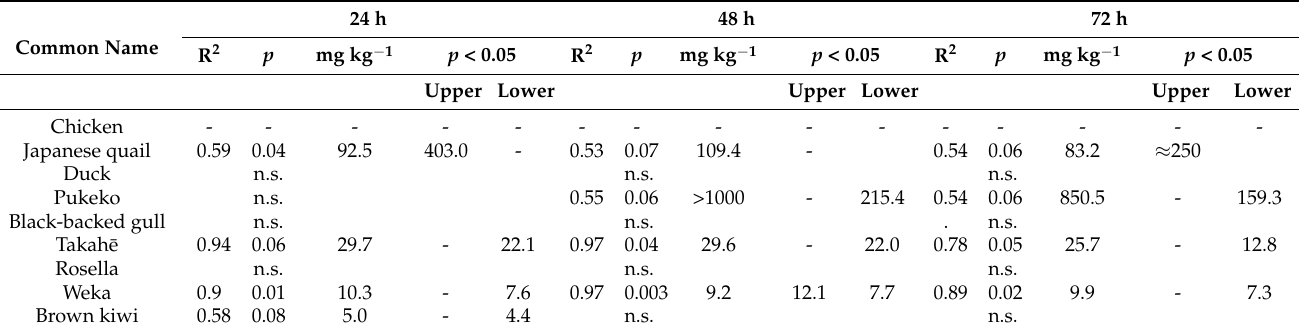
Table 6. Goodness of fit (R 2 ) and significance ( p ) for model of PAPP doses (mg kg − 1 ) given at T0 when projected to exceed 2 SDs of the mean T0 value for packed cell volume (PCV) at 24, 48 and 72 h with upper and lower confidence ( p < 0.05). Null results denote that no shifts beyond 2 SDs were detected.